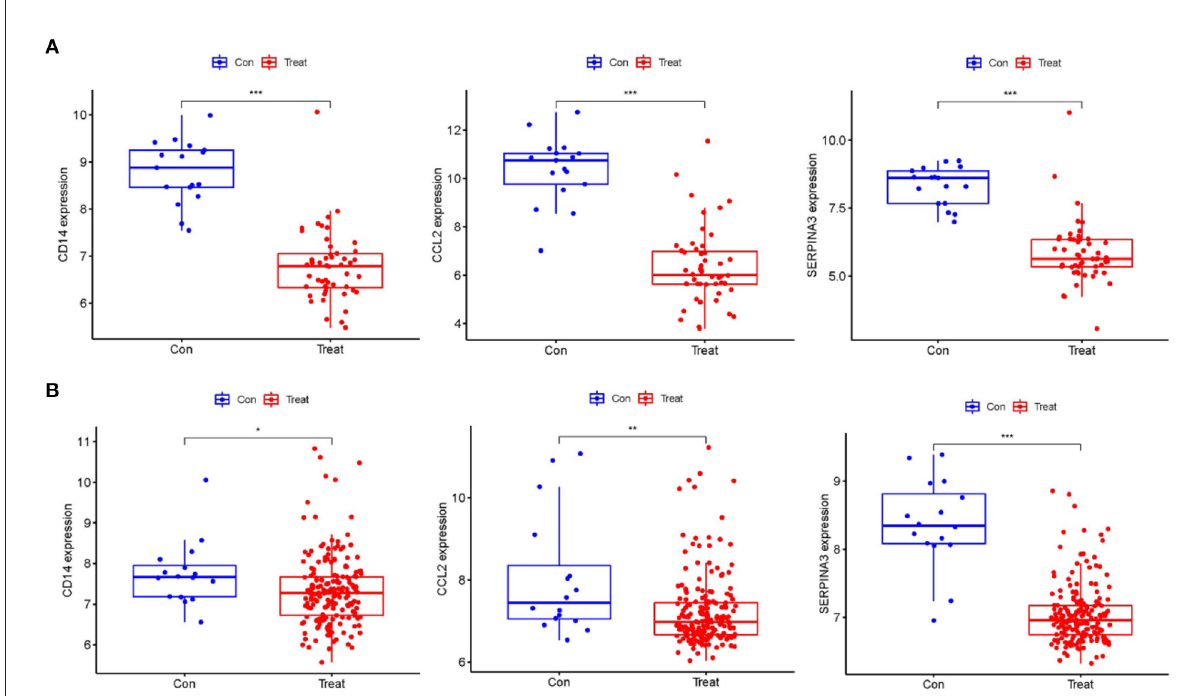
FIGURE4 Identification of the expression level of the Hub gene. (A) The expression levels of hub genes, CD14 , CCL2 and SERPINA3 in the training datasets were significantly lower in the cardiomyopathy group than in the control group. (B) The hub gene expression was verified in the large sample validation dataset (GSE5406), and the expressions of CD14 , CCL2 and SERPINA3 in the cardiomyopathy group were significantly lower than those in the control group, of which SERPINA3 had the most significant difference. “***”, “**”, “*” represent P < (0.001, 0.01, 0.05).